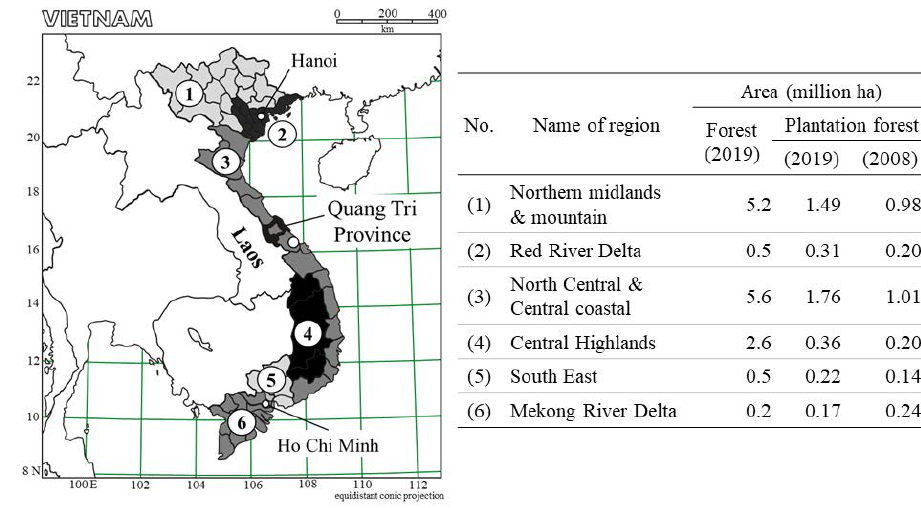
Figure 2. Location of Quang Tri Province and the names and characteristics of regions. Source: